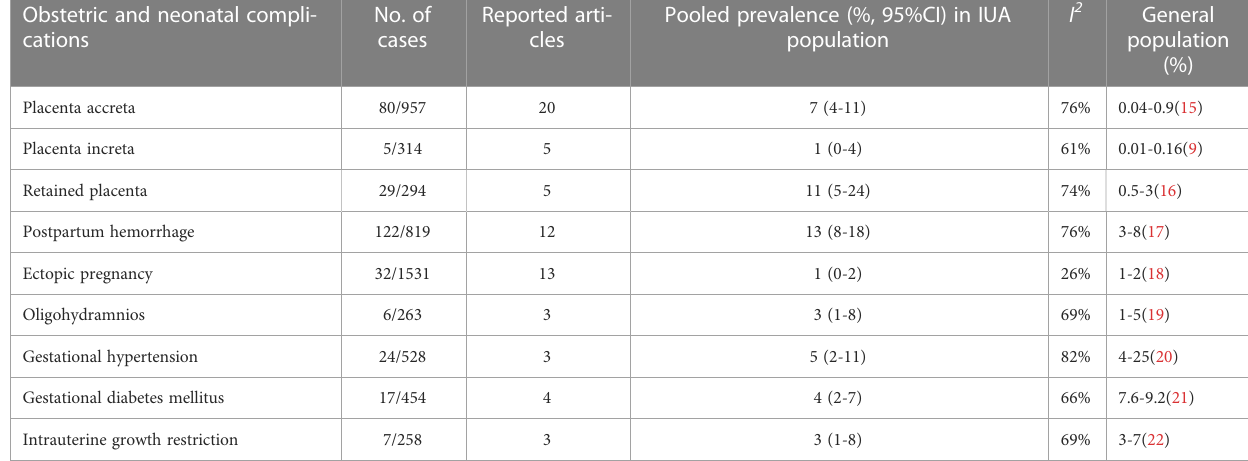
TABLE 2 Prevalence of obstetric and neonatal outcomes after hysteroscopic adhesiolysis in IUA women with the rates in the general population. Obstetric and neonatal compli-